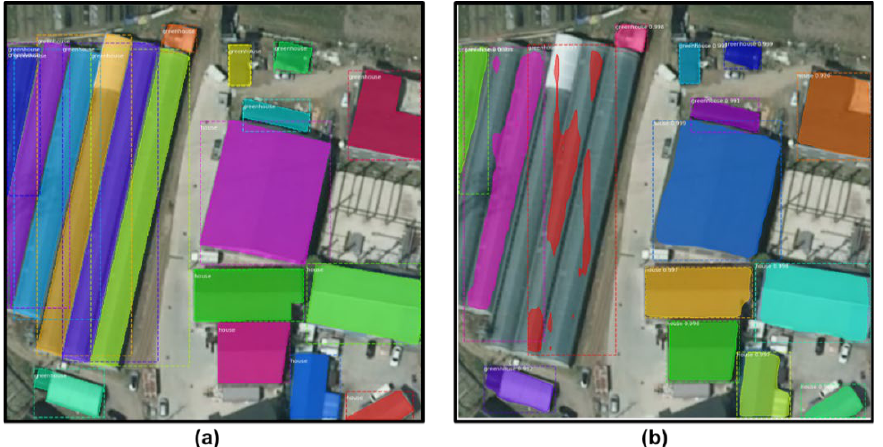
Figure 5. The model results before and after the experiment. ( a ) Annotations in the original image before the experiment. ( b ) Mask and bounding box of detected objects after applying the Cascade Mask R-CNN